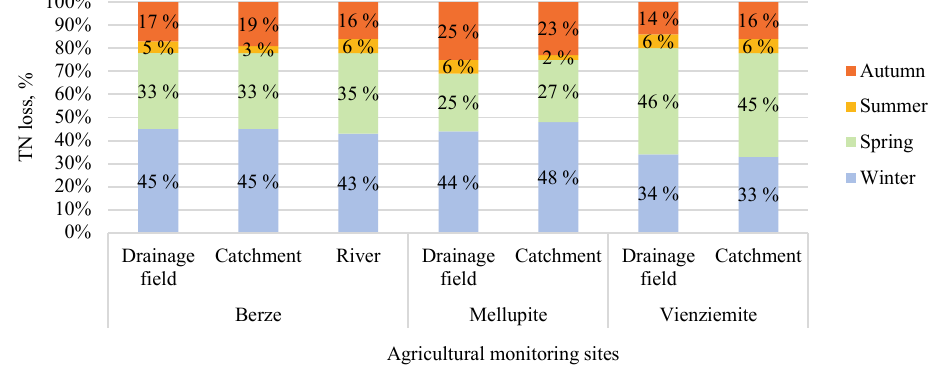
Fig. 8. TN seasonal losses (kg ha –1 ) in agricultural monitoring sites, time period 1995–2020 (drainage field, catchment) and 2005–2020 (river).